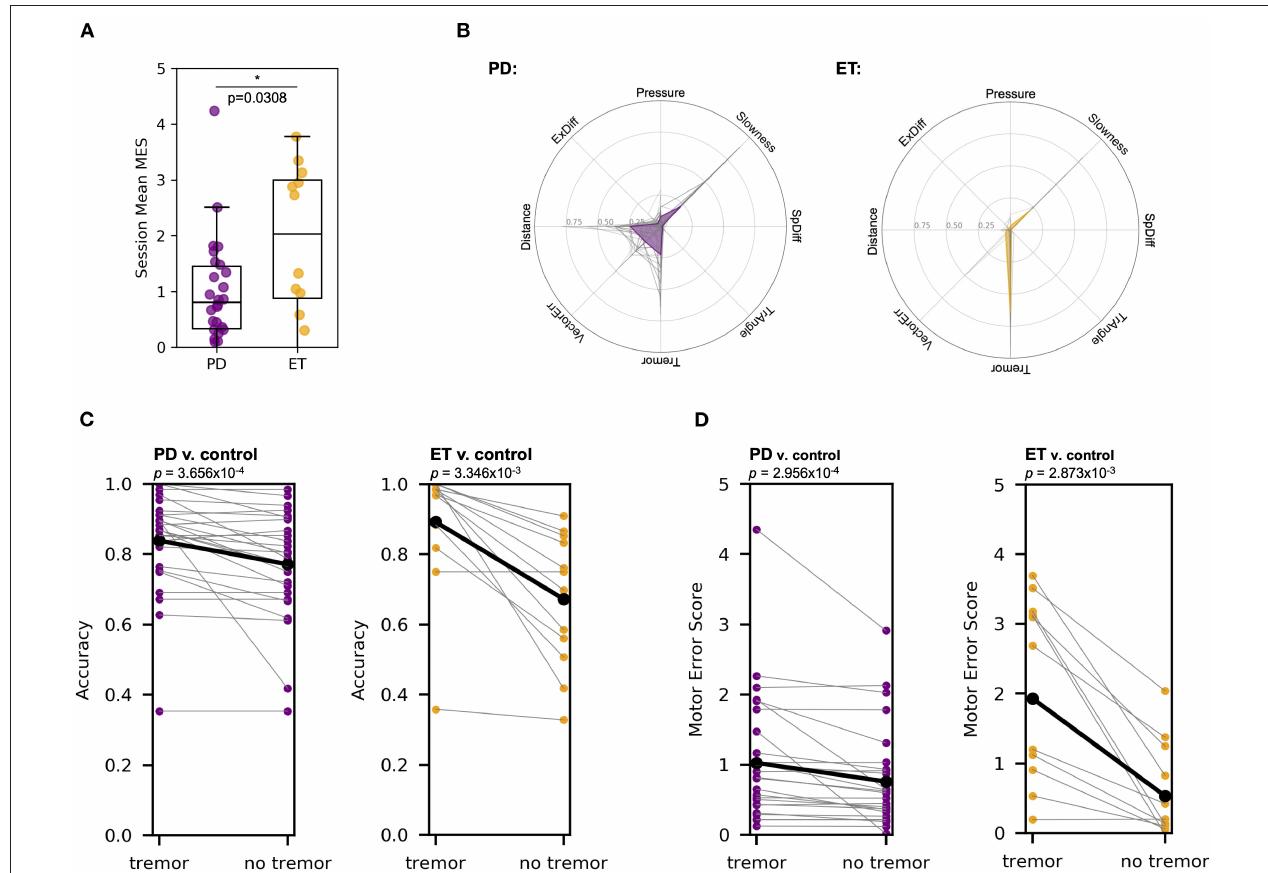
FIGURE 4 | MES metric weights, particularly tremor, differed between patients that have PD compared to ET. (A) Mann-Whitney U test showed that patients with ET have a significantly higher mean MES on a session-to-session basis than patients with PD (U = 96.0, p = 0.0308). Each point represents the mean MES across a single session for a given patient. (B) For the SVM classifier developed for each patient compared to pooled control subject data, the relative contribution of each of the seven different metrics varied. The left plot shows the metric weights calculated for each patient with PD (gray lines) and the mean metric weights across all patients with PD (purple line). The right plot shows a similar analysis for patients with ET (orange line). (C) Removing the “Tremor” metric from the SVM algorithm reduced the accuracy of the resulting classifier in PD v. pooled control (left, purple) and ET v. pooled control (right, orange) comparisons (Wilcoxon signed-rank tests, test statistics were 13.0 and 0.0, while p -values were 3.656 × 10 − 4 and 3.346 × 10 − 3 , respectively). (D) Removing the “Tremor” metric from the SVM algorithm reduced the MES generated in PD v. pooled control (left, purple) and ET v. pooled control (right, orange) comparisons (Wilcoxon signed-rank tests, test statistics were 28.0 and 1.0, while p -values were 2.956 × 10 − 4 and 2.873 × 10 − 3 ,